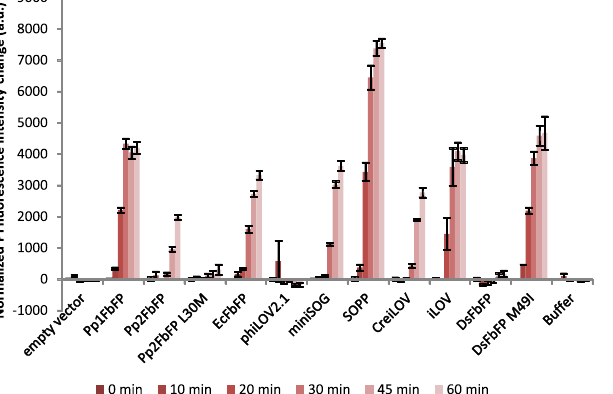
Figure 3. Analysis of LOV-FP phototoxicity using propidium iodide as quantitative marker for dead E . coli cells. The bars show the change in PI fluorescence intensity ( λ ex = 535 nm, λ em = 617 nm) over 60 minutes of blue-light illumination (~10 mW cm − ²). The data was normalized to the amount of functional protein per cell. The corresponding raw data can be found in Supplemental Fig. S1. To ascribe the observed effects to blue-light exposure, a control experiment in the dark was conducted, which showed no significant changes for all tested LOV-PS (Supplemental Fig. S2). The data represent the mean values of three independent experiments, the error bars indicate the calculated standard